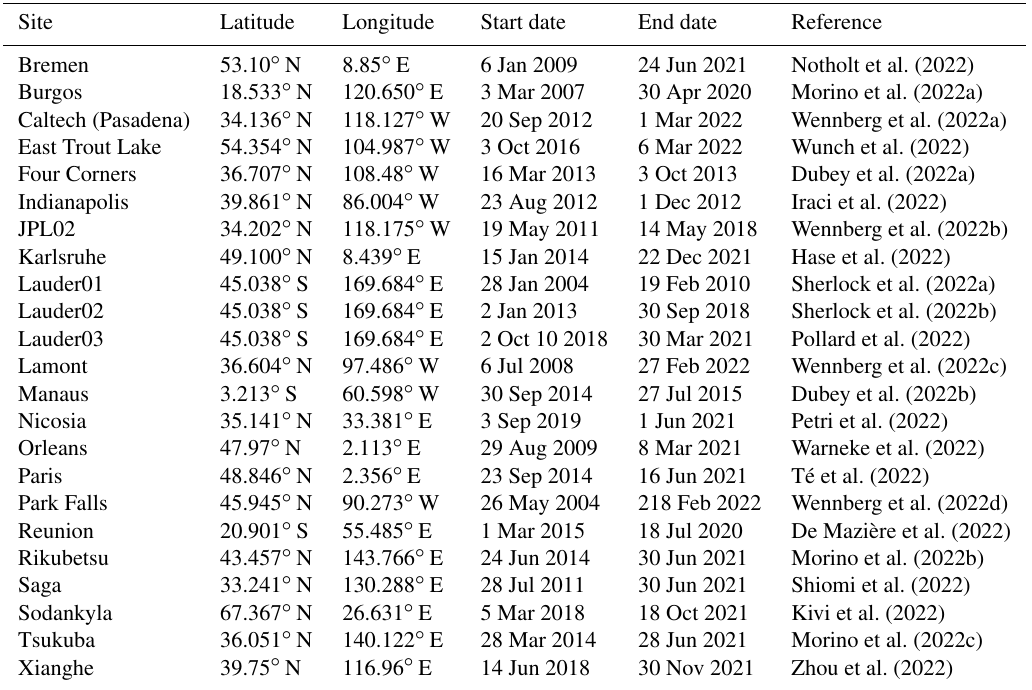
Table B1. Site information of the TCCON GGG2020 data used for